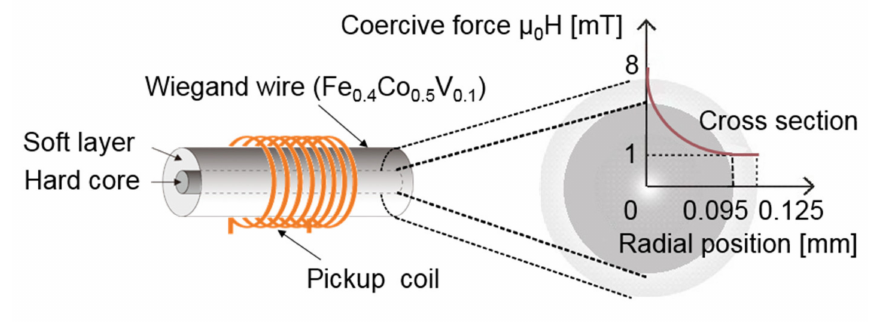
Figure 1. Structure of the Wiegand wire and